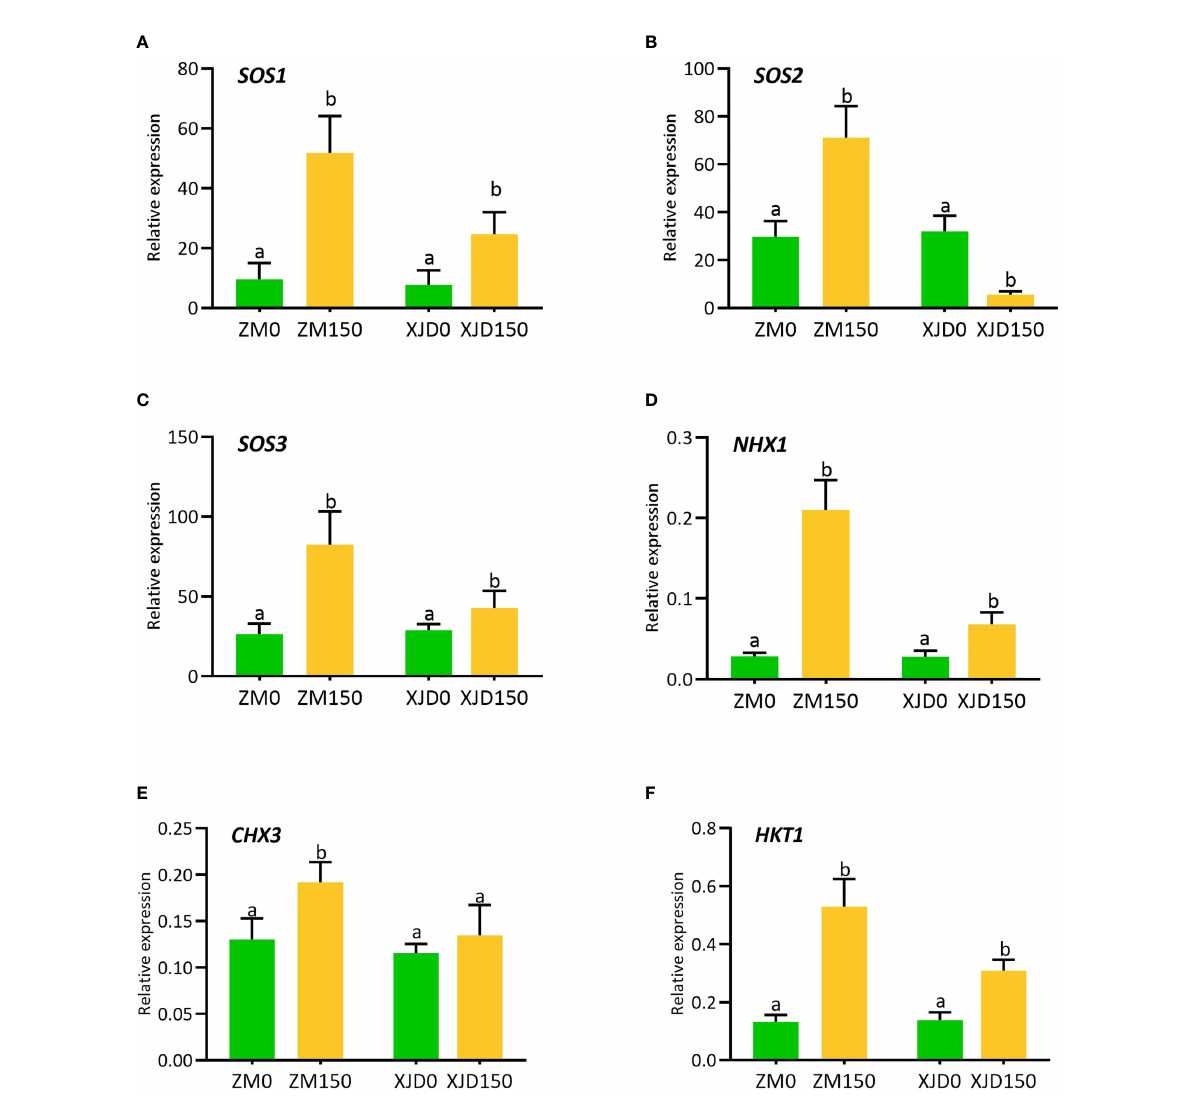
FIGURE 5 Transcript levels of Na + /H + exchanger and Na + /K + transporter genes involved in Na + extrusion, K + uptake, and translocation in two contrasting alfalfa under salt stress. Relative expression of SOS1 (A) , SOS2 (B) , SOS3 (C) , NHX1 (D) , CHX3 (E) , and HKT1 (F) in roots of Zhongmu (ZM) and Xingjiang Daye (XJD) under salt stress. MsActin gene was used to normalize the transcript abundance. The numeric zero (0) indicates salt- untreated (control) plant, while the numeric 150 indicates 150 mM salt treatment. Different letters above the column bar indicate signi fi cant differences among the means ± SD of treatments (n = 3). Data were analyzed by ANOVA and Tukey ’ s tests at p ≤ 0.05 signi fi cant